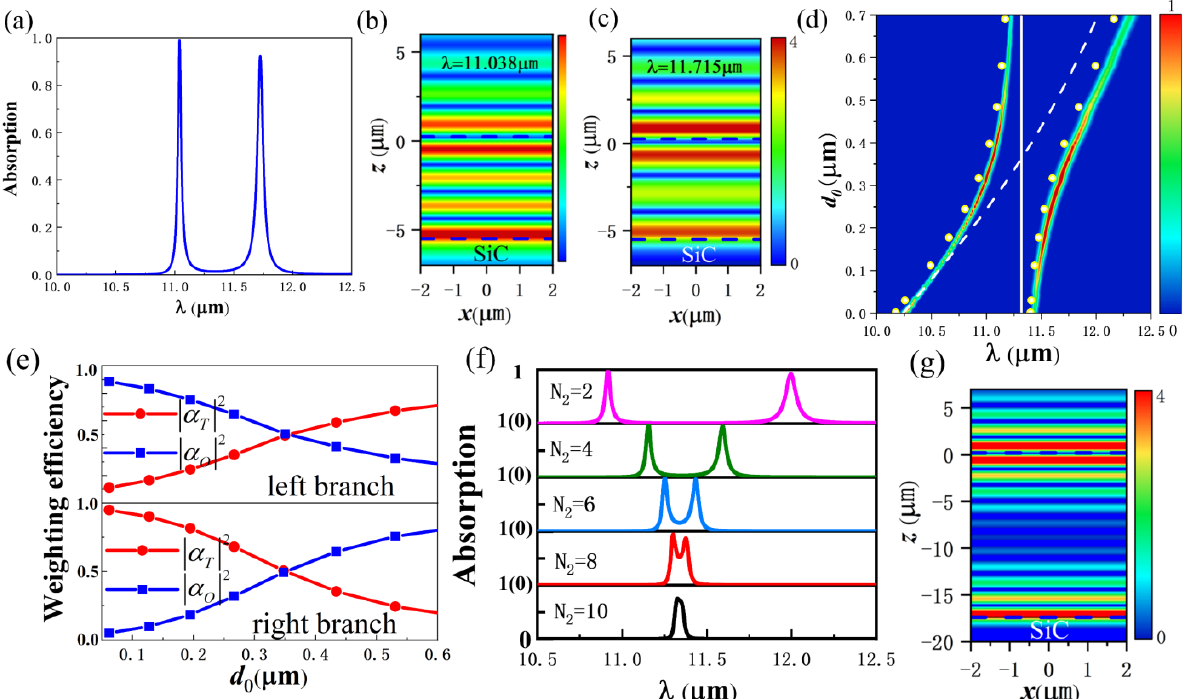
Figure 3. ( a ) The absorption spectrum of PhC1-air layer-PhC2-SiC structure. ( b ) The electric field intensity distribution at 11.038 μm. ( c ) The electric field intensity distribution at 11.715 μm. ( d ) The absorption spectra of OTS and TPhP coupled modes as a function of d 0 . ( e ) The mixing fractions of OTS and TPhP as a function of d 0 . ( f ) The absorption spectra of the structure when the period number N 2 of PhC2 is different. ( g ) When N 2 = 10, the electric field intensity distribution of the structure at the resonance wavelength.